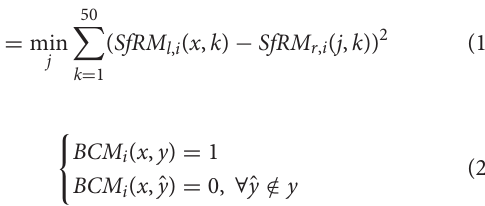
registered by a UA in ith row and jth column of left retinal LumM (replace l by r to represent right retina). In Equation (1), the squared difference between the frequency-contents of the corresponding left- and right-eye patches are